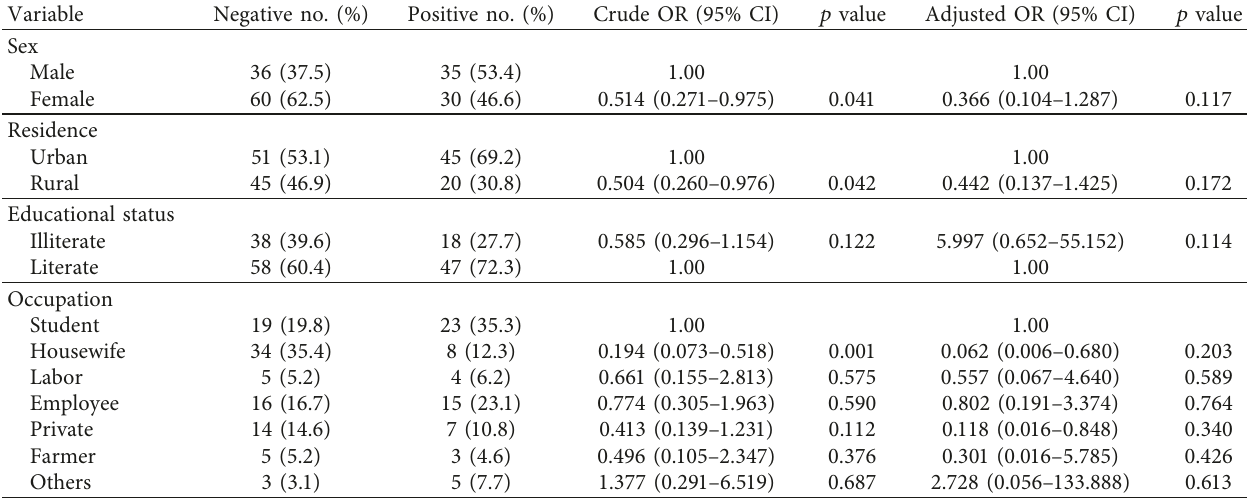
Table 2: Multivariate analysis of MRSA and sociodemographic factors from wound infected patients attending Arba Minch Hospital, Arba Minch, South Ethiopia, April to June